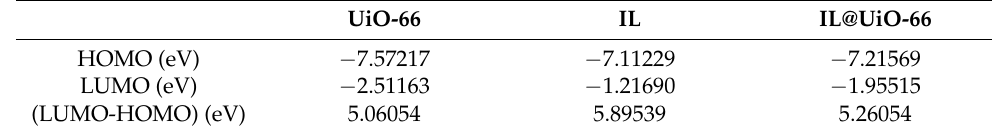
Figure 17. The molecular orbital energy diagram of the highest occupied molecular orbital (HOMO) and lowest unoccupied molecular orbital for UiO-66 linkers and IL@UiO-66. Table 3. The value of the highest occupied molecular orbital (HOMO) and lowest occupied molecular orbital (LUMO) for UiO-66, IL and